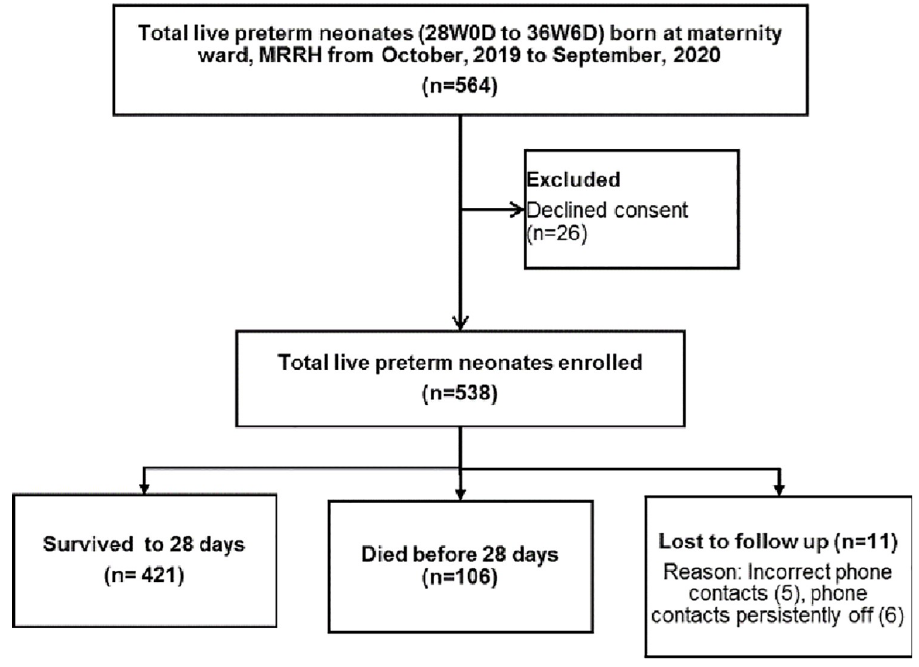
Fig 1. Study flow